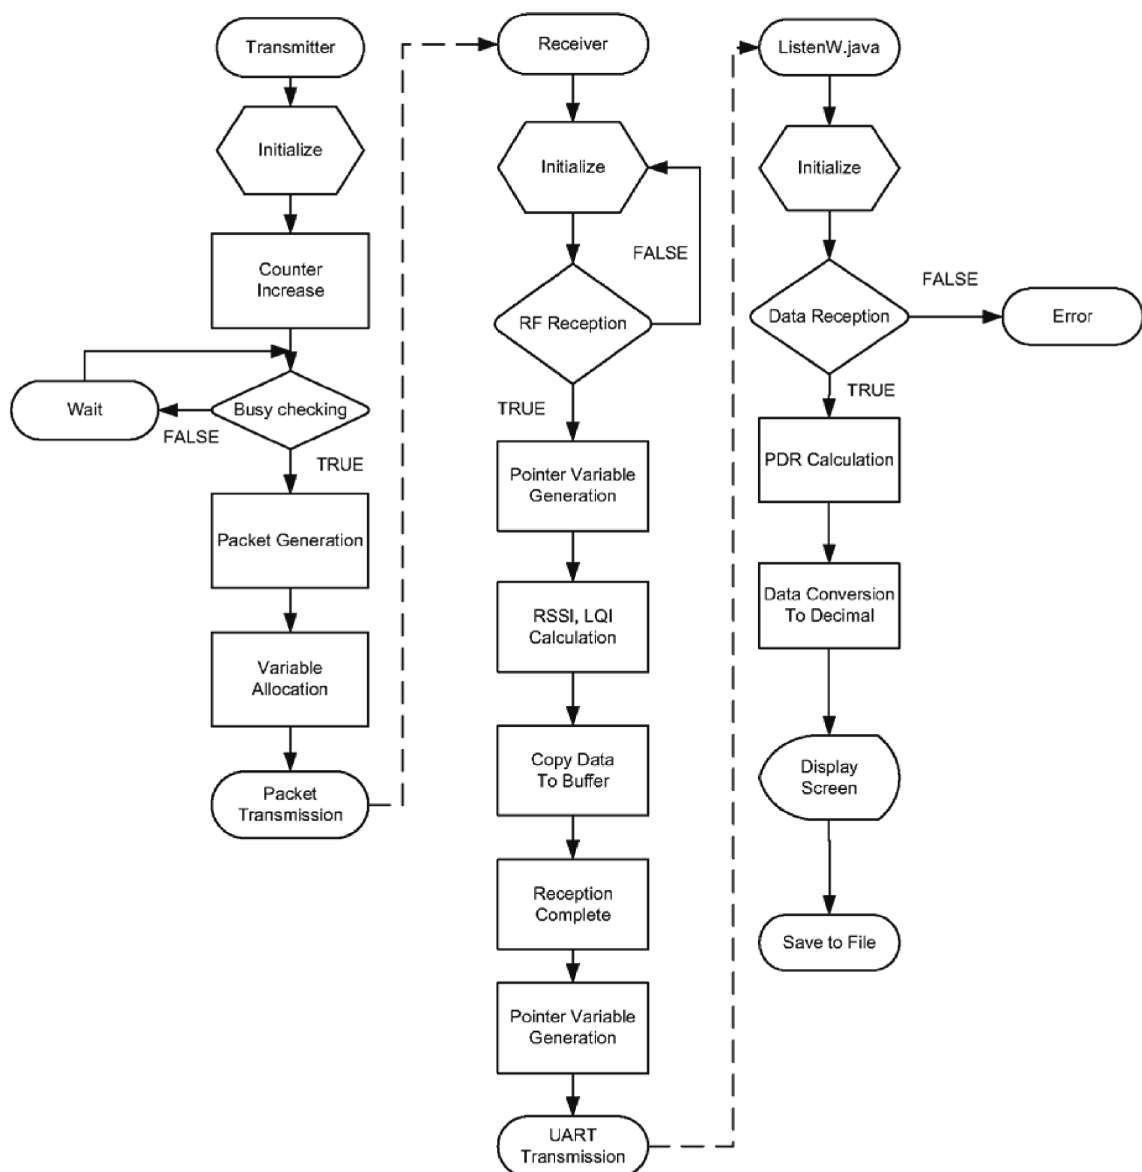
Fig. 2. Flowchart of a Zigbee programming